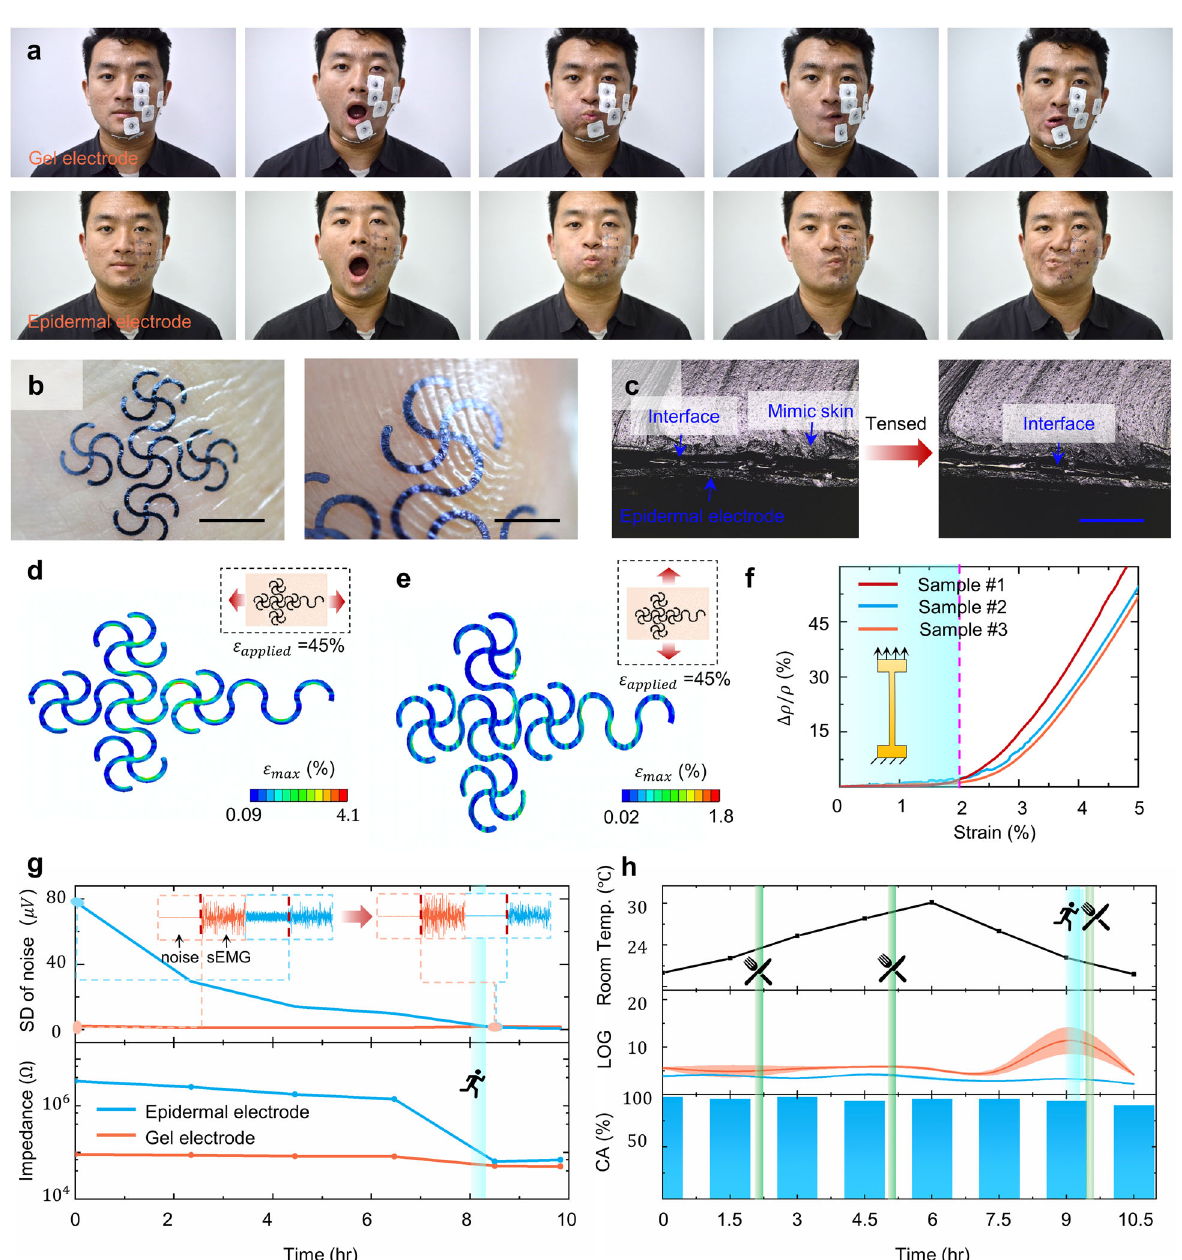
Fig. 2 Characterizations of tattoo-like electrodes. a The wearability of tattoo-like electrodes and gel electrodes when attached on the subject ’ s face. The identi fi able photographs are fully consented by the written consents. b The tattoo-like electrodes conform with skin textures at different scales. The scale bars on the left and right panel are 6 and 2.5 mm, respectively. c The skin – electrode interface before and after being stretched by 30%. The scale bar is 150 μ m. d , e The strain distributions of tattoo-like electrodes under horizontal and vertical tensing with 45%. f The resistivity changes of gold ribbons with respect to strain. g The long-term measurement to investigate the change of background noise and impedance. The standard deviation (SD) characterizes the strength of background noises. h Long-term measurement of log detector (LOG) and classi fi cation accuracy long-term wear can affect the background noise, it is reasonable impedance highly depend on the skin – electrode interface and to consider the effect of daily usages on sEMG. Thus, we study the skin properties 38 . The chloride ions contained in gel electrodes effect of complicated daily activities on signal features and freely permeate through the stratum corneum, signi fi cantly classi fi cation accuracy. Tattoo-like electrodes and gel electrodes suppressing noise and impedance. After running, both electrical were, respectively, attached on the left and right faces. The subject parameters of tattoo-like electrodes sharply go down and the was required to dine at the 2.3th hour, 5th hour, and 9.5th hour noise is even weaker than that of gel electrodes. It is mainly and run for 20 min at the 9th hour. Additionally, the room because, during the test, the Tegaderm fi lm prevents the temperature gradually rises to 30.1 from 20 °C in 6 h and then evaporation of sweat, and the sweat goes through the stratum declines to 19.8 °C in 4.5 h, shown in the upper panel in Fig. 2h. corneum and fi nally accumulates at the skin – electrode interface, The middle panel in Fig. 2h plots the log detector (LOG) of the fi rst dramatically reducing the noise and impedance. Now that the